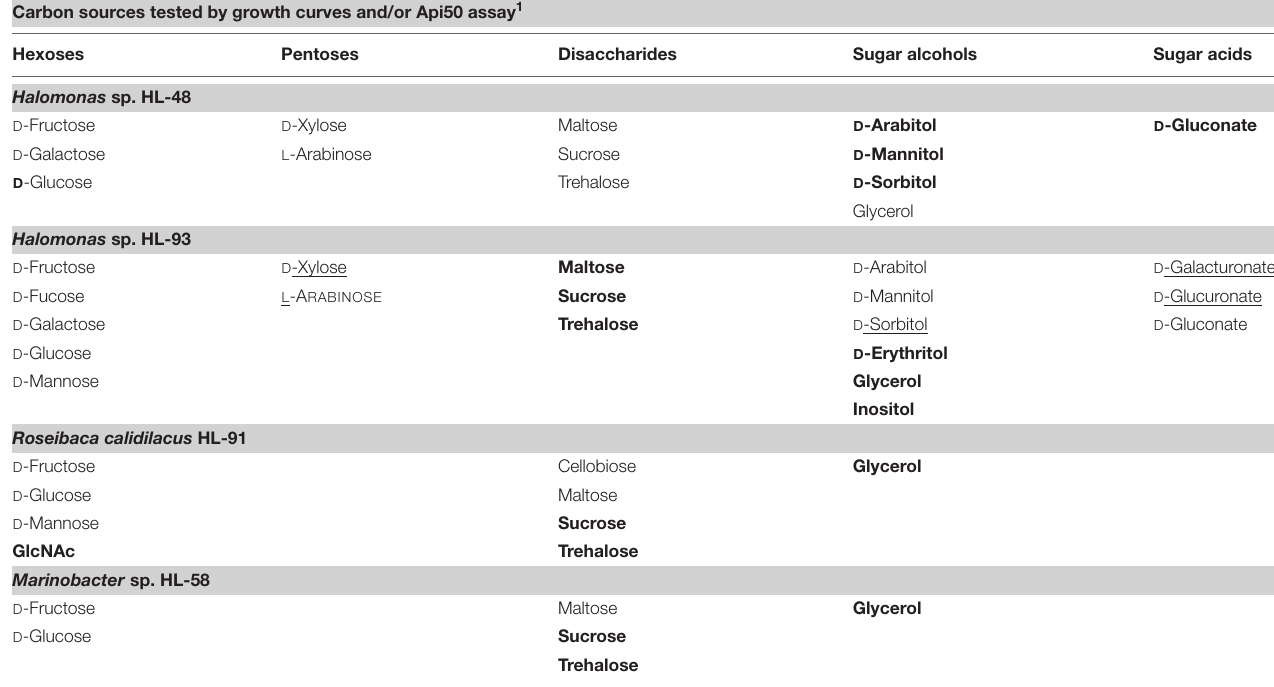
TABLE 2 | Carbon sources that support growth of four heterotrophic UCC members. Carbon sources tested by growth curves and/or Api50 assay